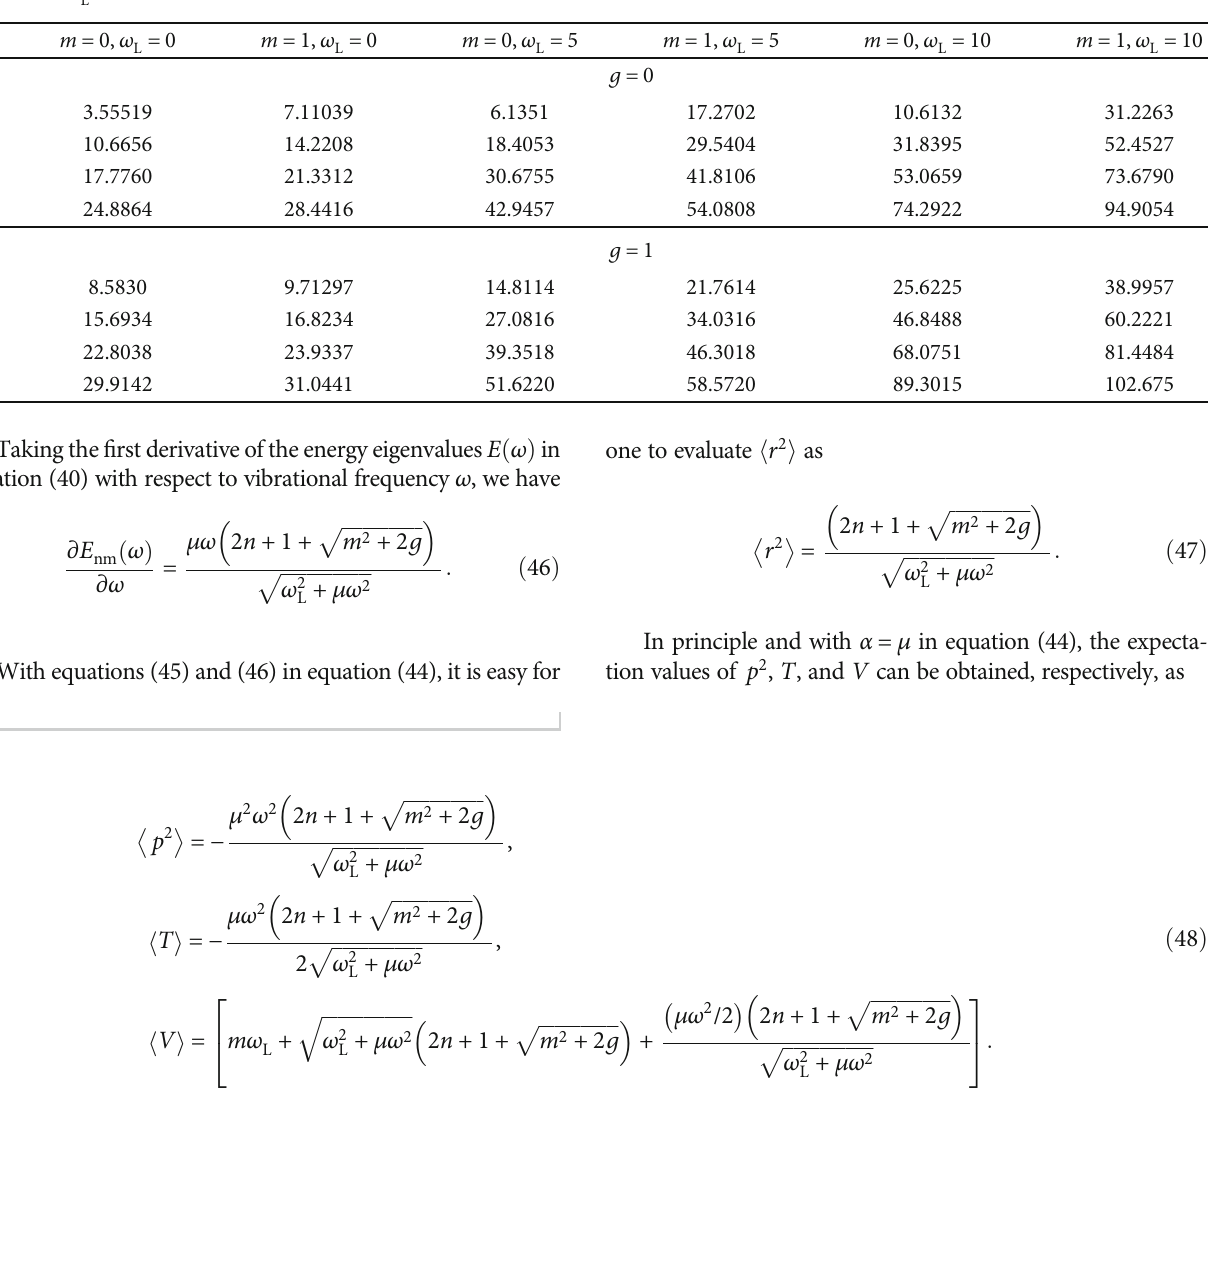
Table 4: Energy spectra for HCl molecules bounded by the isotropic oscillator plus inverse quadratic potential for arbitrary Larmor frequencies ω . L